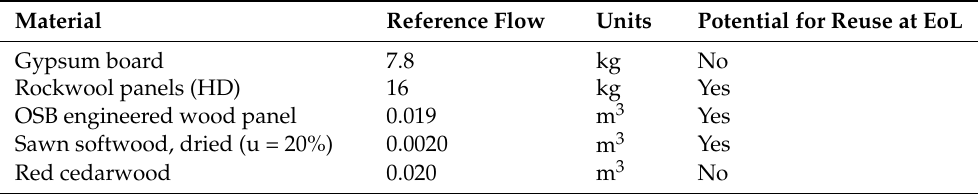
Table 1. Bill of materials for one functional unit (FU = 1 m 2 ) of traditional timber framing wall assembly. Reference flow = amount of material required per FU.